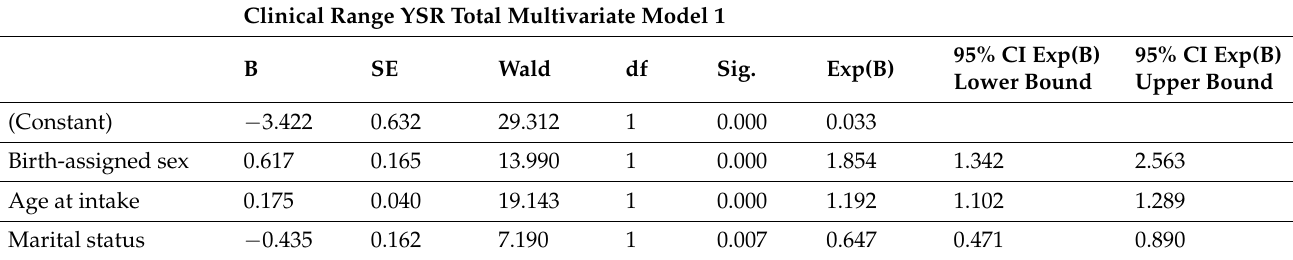
Table 5. Multiple logistic regression for BIS total score and YSR clinical range